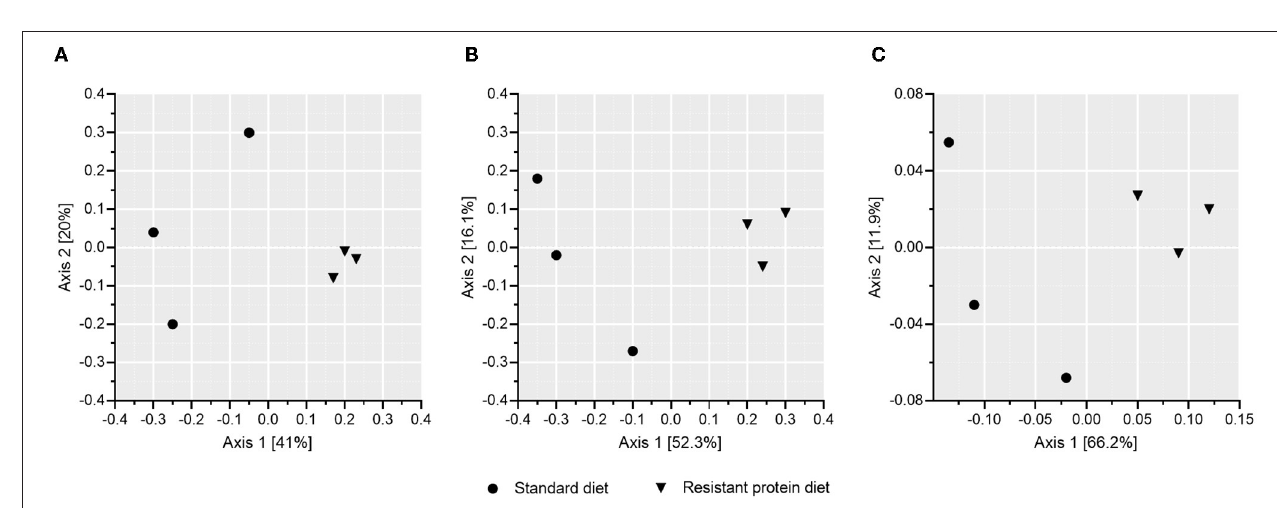
FIGURE 5 | The effects of standard and resistant protein diet on pig microbiota at day 20 showing effects on β -diversity according to mean scores of (A) unweighted Unifrac, (B) Bray–Curtis, and (C) weighted UniFrac analyses (presence/abundance of taxa), which indicate significant differentiation of the microbial composition due to diets ( n = 3 pigs per treatment, all p <